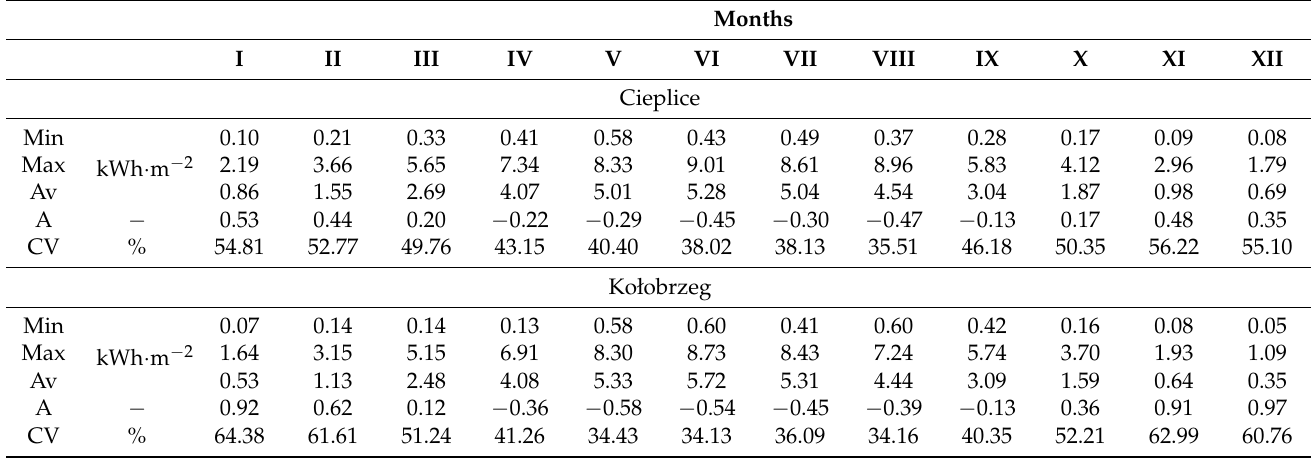
Table A2. Selected statistical characteristics of daily sums of global solar radiation in Cieplice and Kołobrzeg. Data for the years 1996–2015.